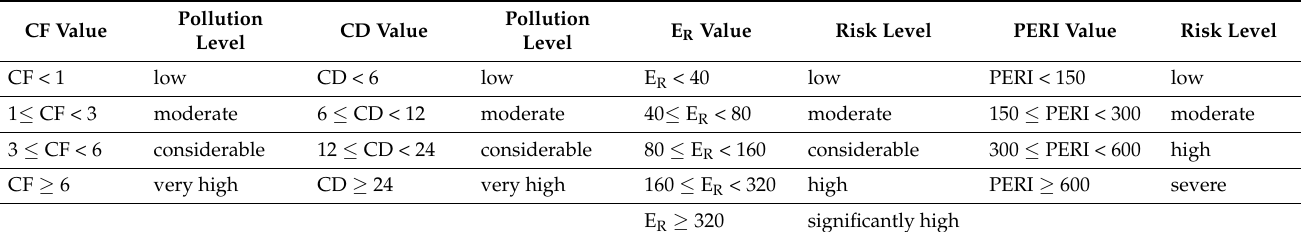
Table 1. The adjusted grading standards of CF, CD, E R , and PERI according to Håkonson [35].